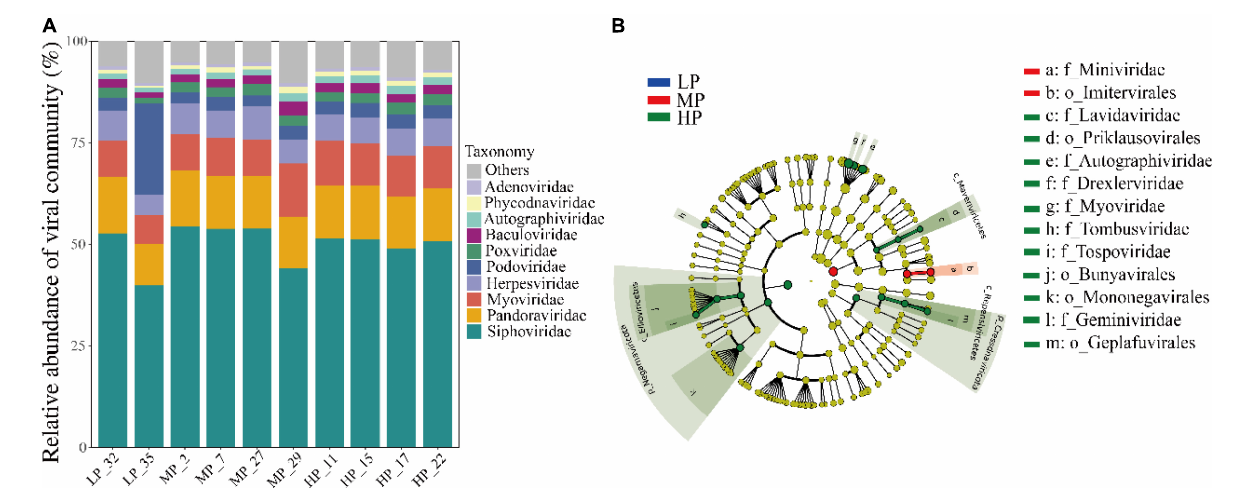
FIGURE 3 | Taxonomic composition of soil viruses in the Tibetan Plateau, assessed for all virus-associated reads at the family level (A) . Only the top ten viral families were shown. Viral biomarkers in different precipitation based on LEfSe analysis (B) . Different colors represent different precipitation gradients and the circles from inside to outside correspond to kingdom to